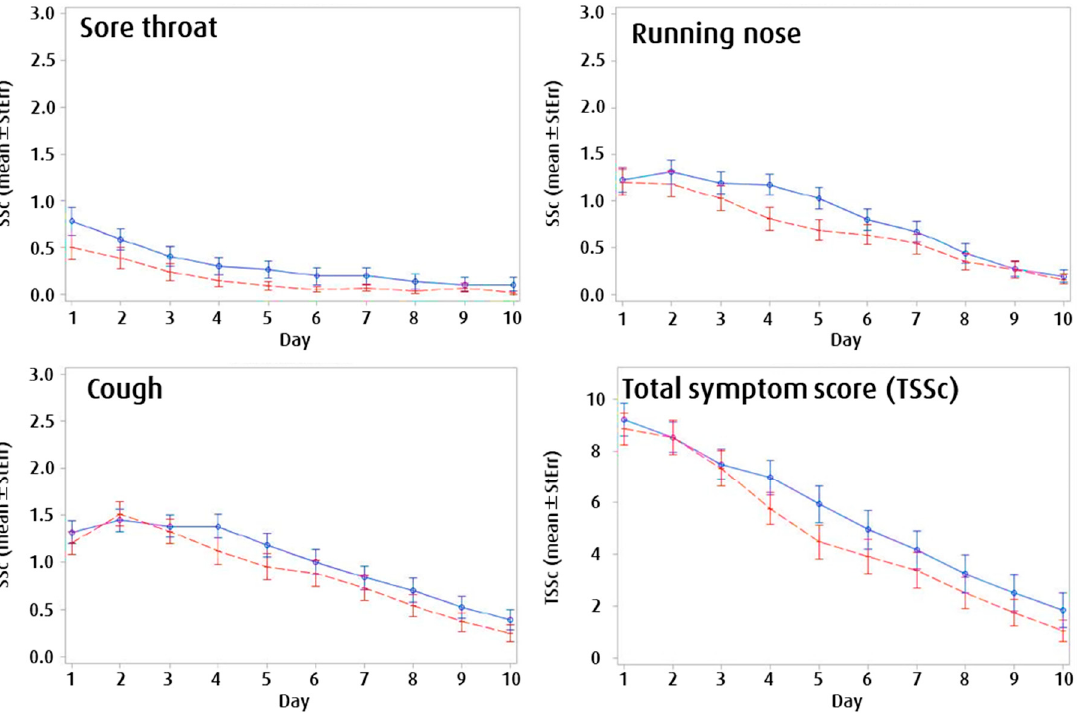
Figure 4. Single symptom scores (SScs) for sore throat, cough, and running nose (ITT: Intention to treat collective). Total daily symptom score (TSSc) was calculated by aggregating the severity scores of all measured cold symptoms. The course of symptoms is indicated with solid blue lines for children in the low-dose group (3 × 1 tablets daily), and with red dashed lines for children in the high-dose group (5 × 1 tablets daily).